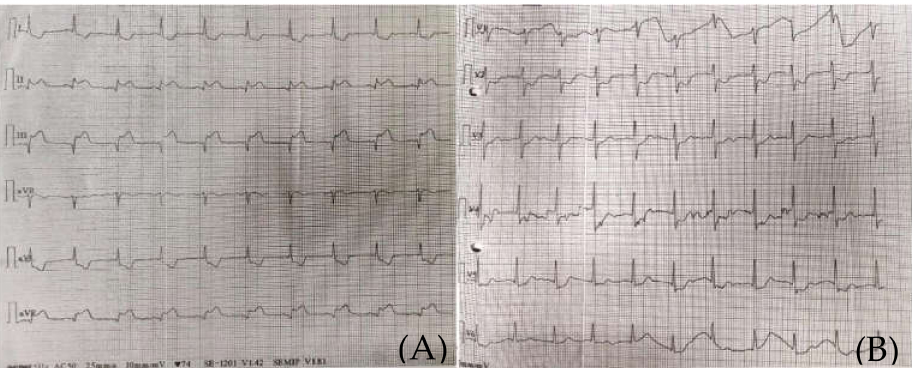
Figure 1. ( A ) (standard limb leads) and ( B ) (standard precordial leads). Emergency room 12-Lead ECG presenting an inferior myocardial infarction, ST-T segment elevation.